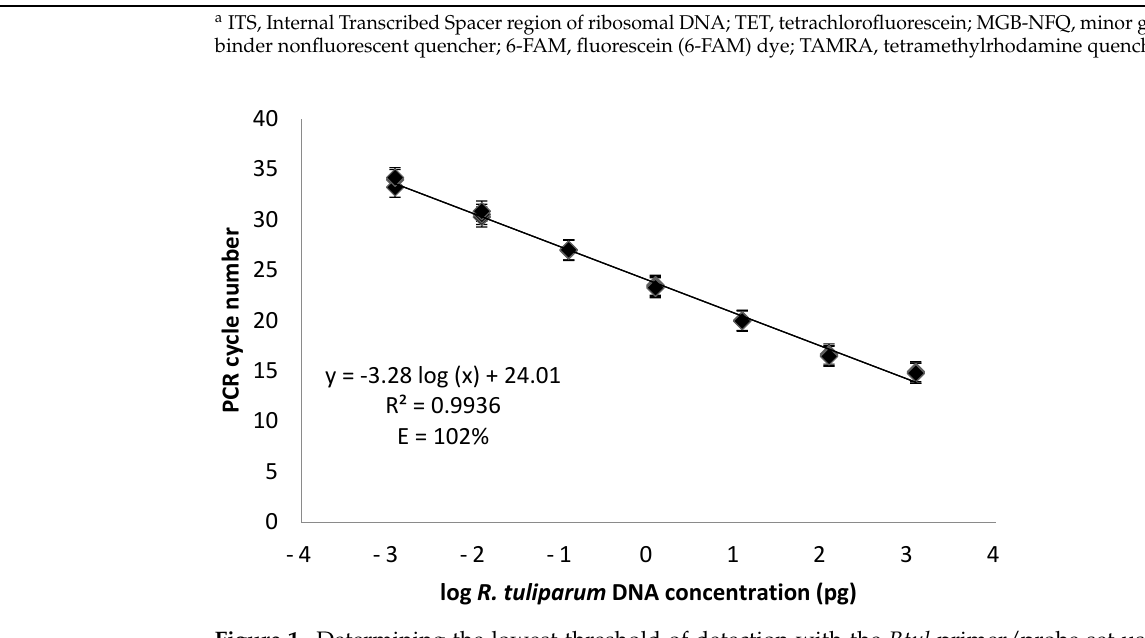
Figure 1. Determining the lowest threshold of detection with the Rtul primer/probe set used in this study. 1:10 serial dilution series (1.2 ng µ L − 1 –0.12 fg µ L − 1 of DNA) of Rhizoctonia tuliparum (DGF2-VV) DNA analyzed in triplicate with qPCR. The log DNA concentration versus cycle threshold was plotted and a regression line drawn for the